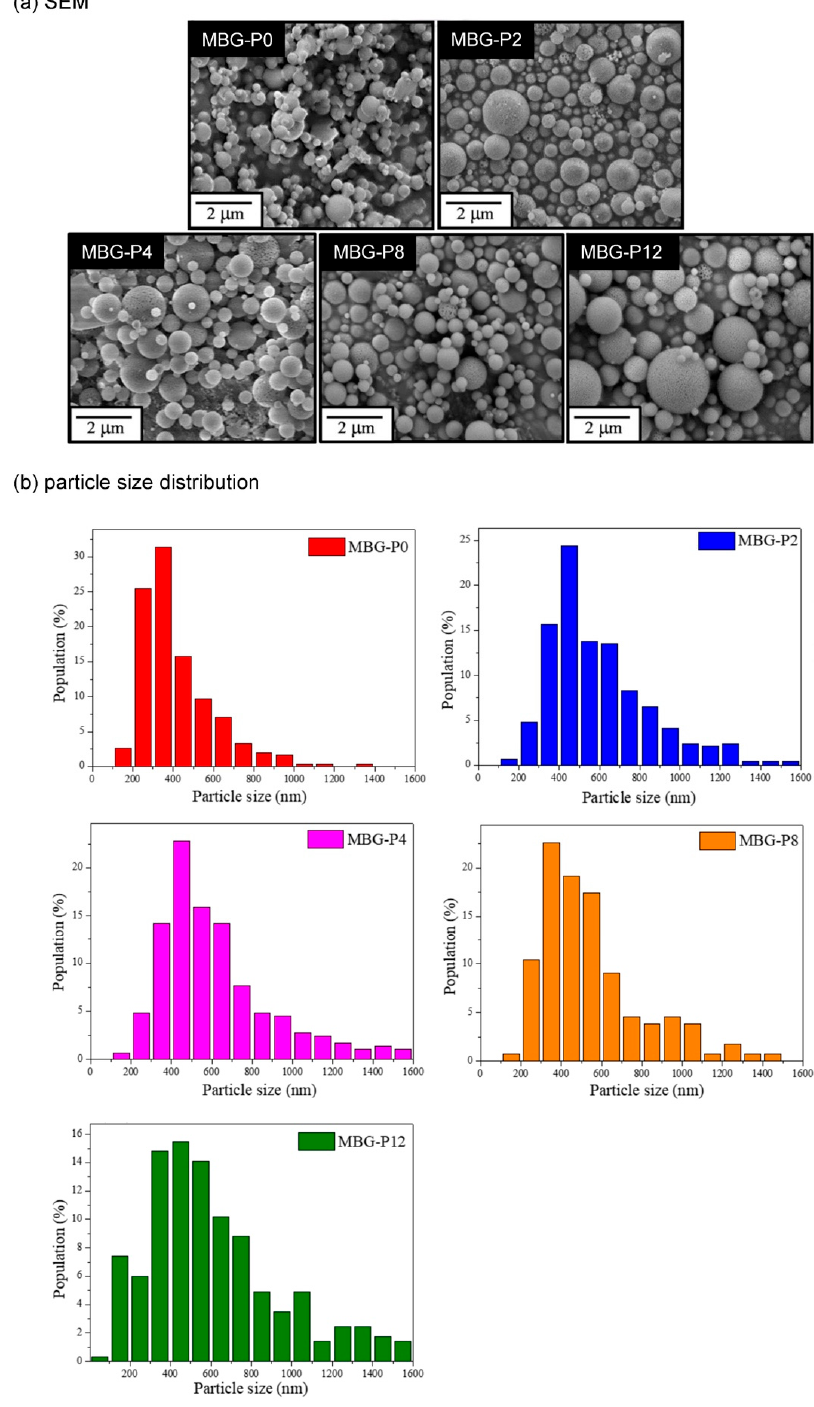
Figure 2. The FE- SEM images ( a ) and particle size distribution ( b ) of MBG adding different molecular weights of PEG.